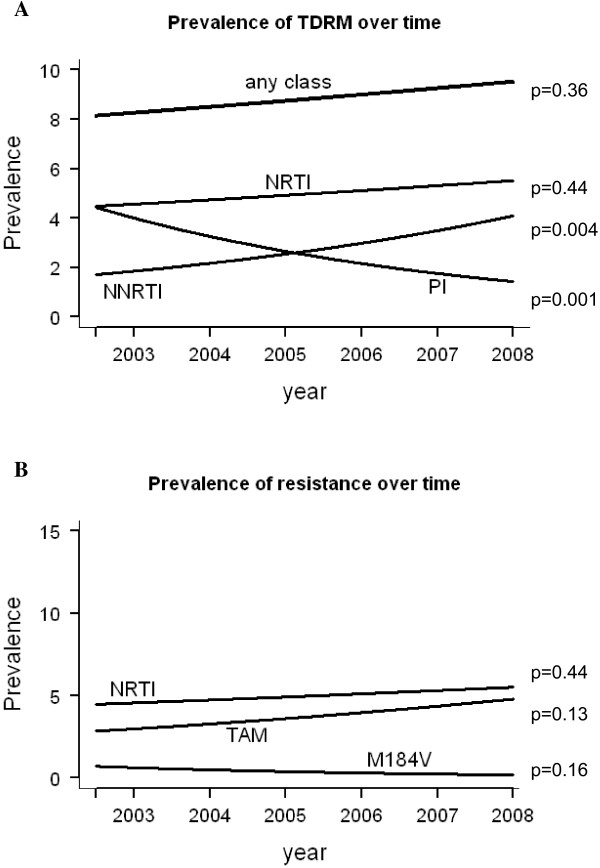
Smoothed line of prevalence of TDRM in patients diagnosed from 2002 to 2007 at time of sequence sampling. (A) Prevalence of TDRM associated with any of the drug classes (any class), nucleoside reverse-transcriptase inhibitor (NRTI), nonnucleoside reverse-transcriptase inhibitor (NNRTI), and protease inhibitor (PI). (B) Prevalence of mutations associated with nucleoside reverse-transcriptase inhibitors (NRTI), thymidine analogue mutations (TAM) and revertants, and the M184V mutation. The p-values of the time trends are shown. The multivariate time trend analyses did not change the time trend estimates and significance.